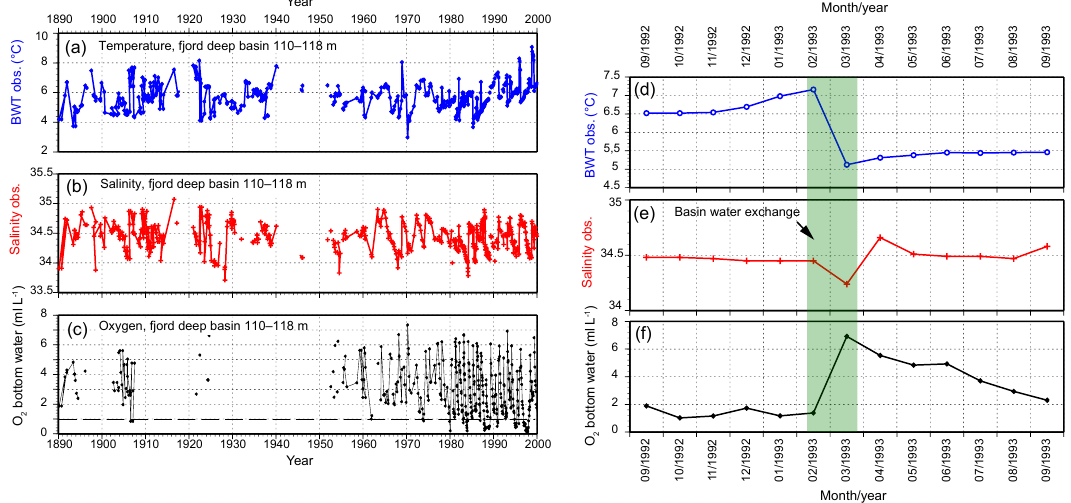
Figure 2. Hydrographic measurements from Alsbäck Deep, Gullmar Fjord taken during the 1890–2000 period below a water depth of 110m: bottom water temperatures (BWT) (a) , salinity (b) and dissolved oxygen (c) . A snapshot of the hydrographic changes in BWT (d) , salinity (e) and oxygen (f) associated with basin water exchanges between 1992 and 1993 showing annual variability of these